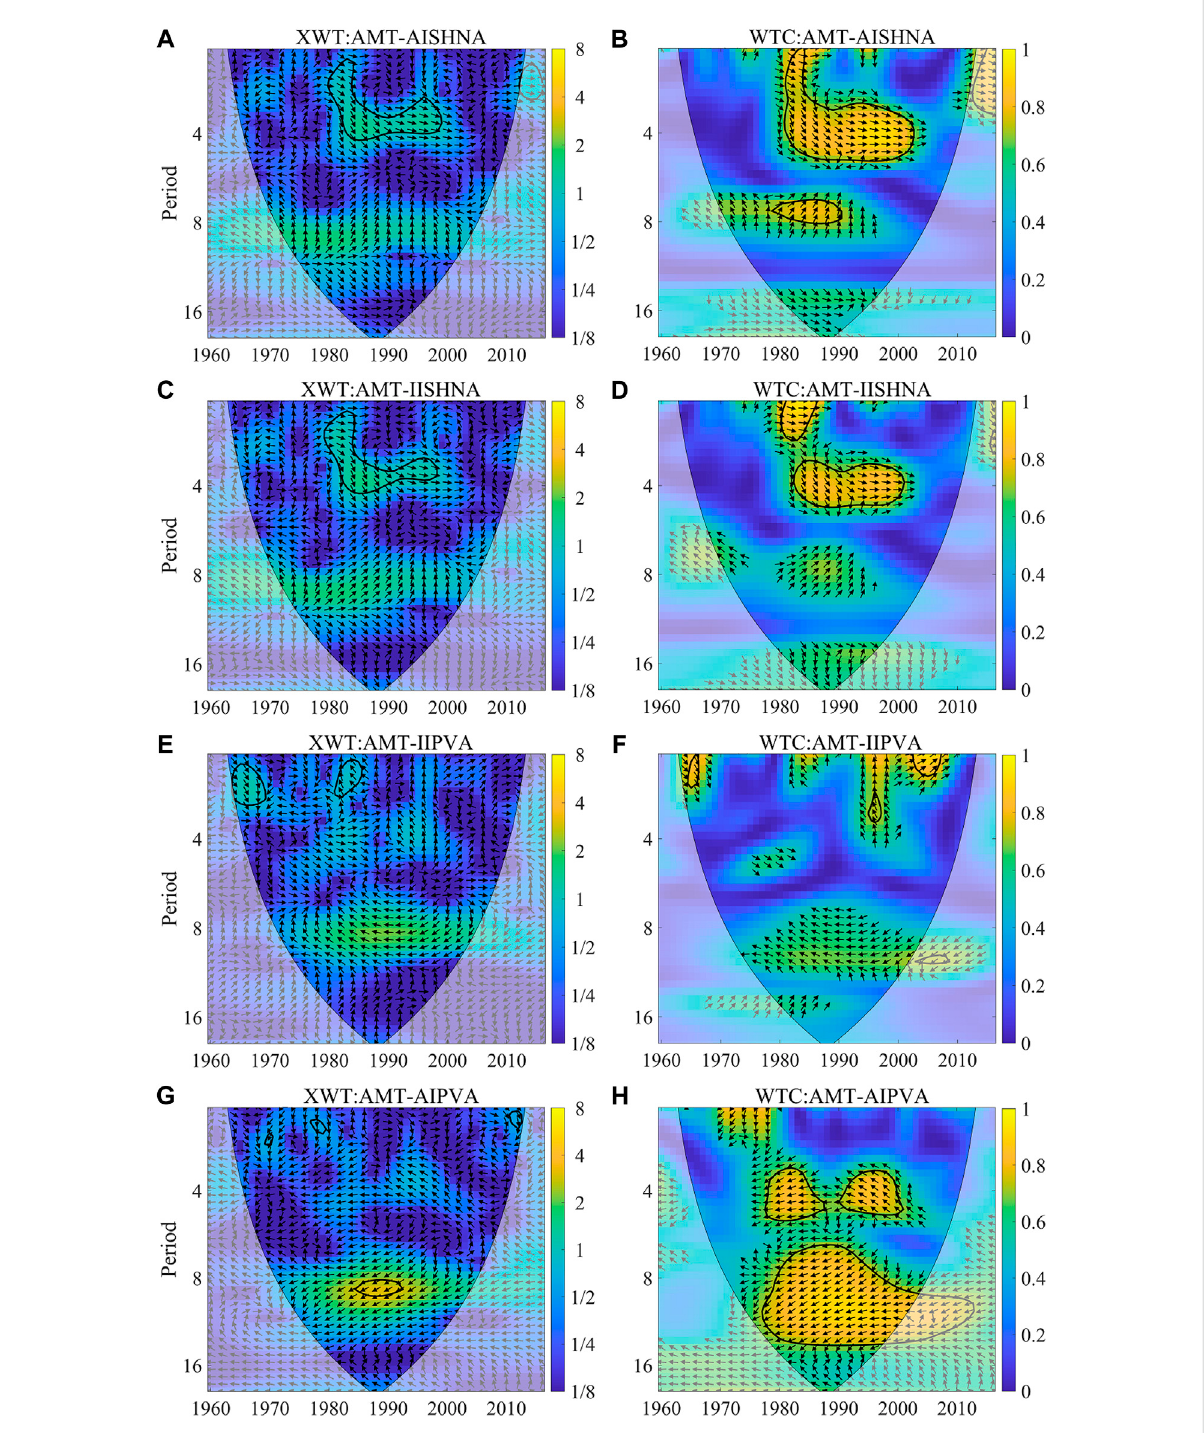
FIGURE 7 XWT and WCT of the annual mean temperature (A – H) in XJ to the area index of the subtropical high over North Africa, Atlantic, and North America (AISHNA), the intensity index of the subtropical high over North Africa, Atlantic, and North America (IISHNA), the intensity index of the polar vortex in Asia (IIPVA), and the index area of Asia polar vortex